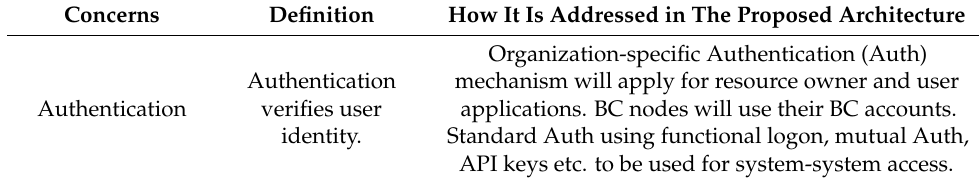
Table 7. Qualitative Evaluation of Security and Privacy